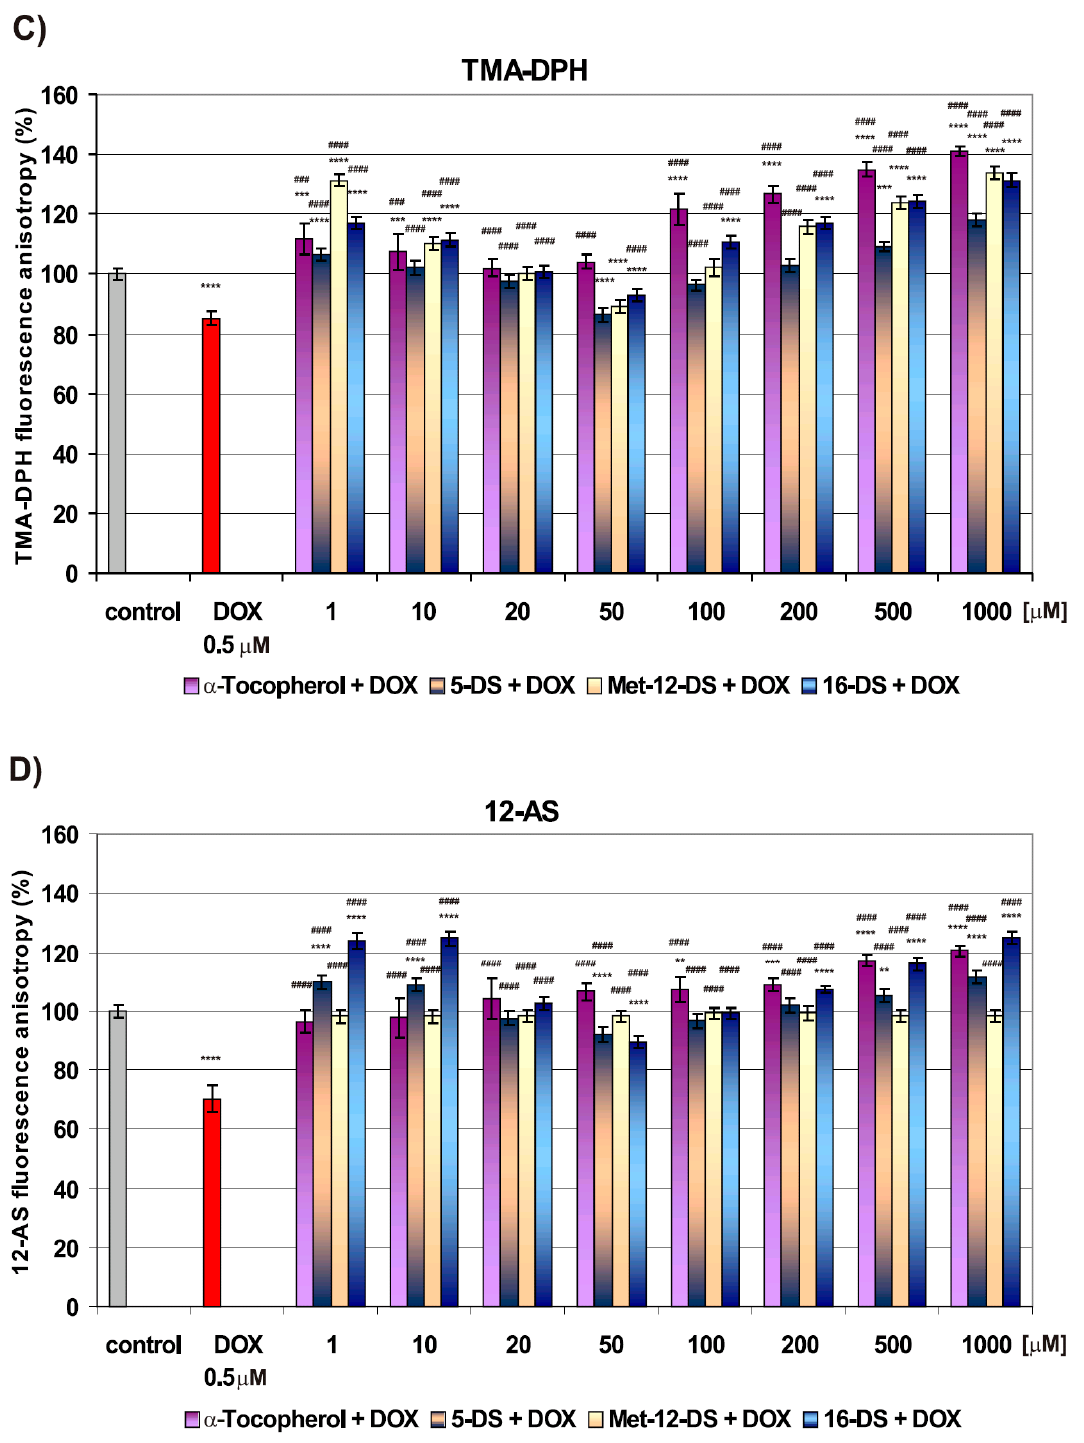
Figure 5. The influence of doxyl stearate nitroxides: 5-DS, Met-12-DS, and 16-DS and α -Tocopherol administered alone ( A , B ) or in combination with 0.5 µ M doxorubicin (DOX) ( C , D ) on fluidity of the plasma membrane of B14 cells measured fluorimetrically using 1-(4-trimethylammoniumphenyl)-6-phenyl-1,3,5-hexatriene (TMA-DPH) ( A , C ) and 12-AS ( B , D ) fluorescent probes (Sections 4.1.1 and 4.2.4). The data are shown as a mean ± SD. ** p < 0.01 vs. control; *** p < 0.001 vs. control; **** p < 0.0001 vs. control; ### p < 0.001 vs. DOX; #### p < 0.0001 vs. DOX.